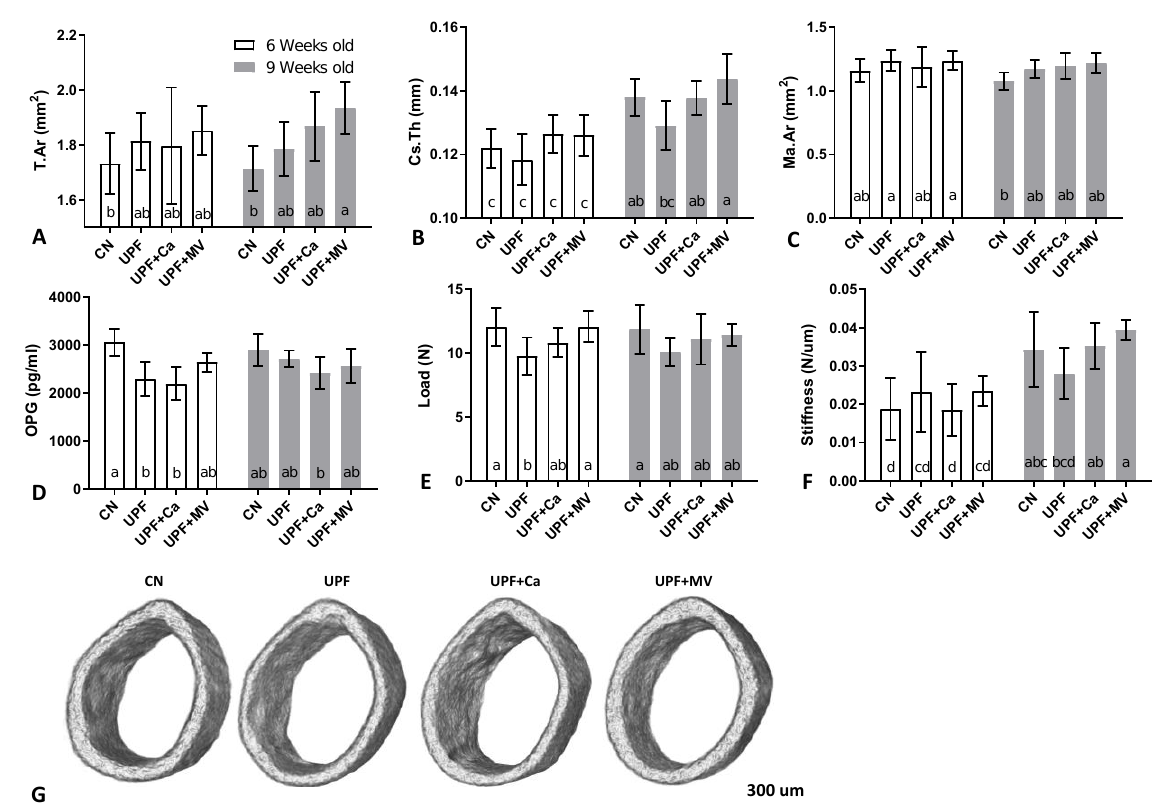
Figure 4. UPF effect on mechanical integrity and cortical compartment of mice at 6 and 9 weeks of age. ( A ) Mean total area (mm 2 ). ( B ) Crossectional thickness (mm) ( C ) Medullary area (mm 2 ) ( D ) Serum osteoprotegrin (pg/mL) ( E ) Yield load (N) ( F ) Linearity slope (n/um) ( G ) 3D reconstruction of cortical shell at 9 weeks of age. Values are expressed as mean ± SD, n = 8. Different letters denote p < 0.05 between groups. CN – control, UPF – ultra processed food, UPF+Ca - ultra processed food supplemented with calcium, UPF+MV - ultra processed food supplemented with multivitamin and mineral complex.